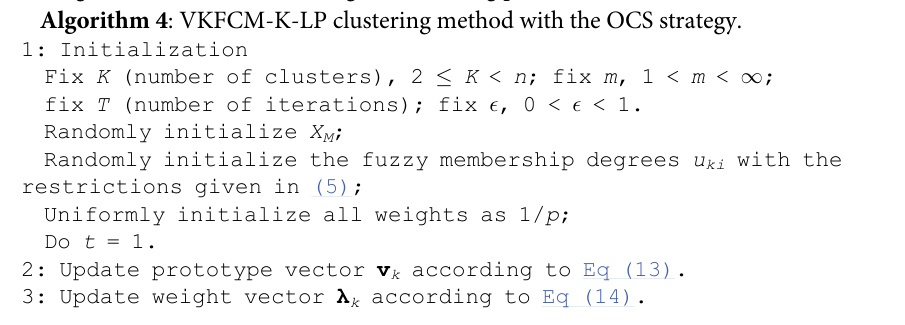
Algorithm 4 : VKFCM-K-LP clustering method with the OCS